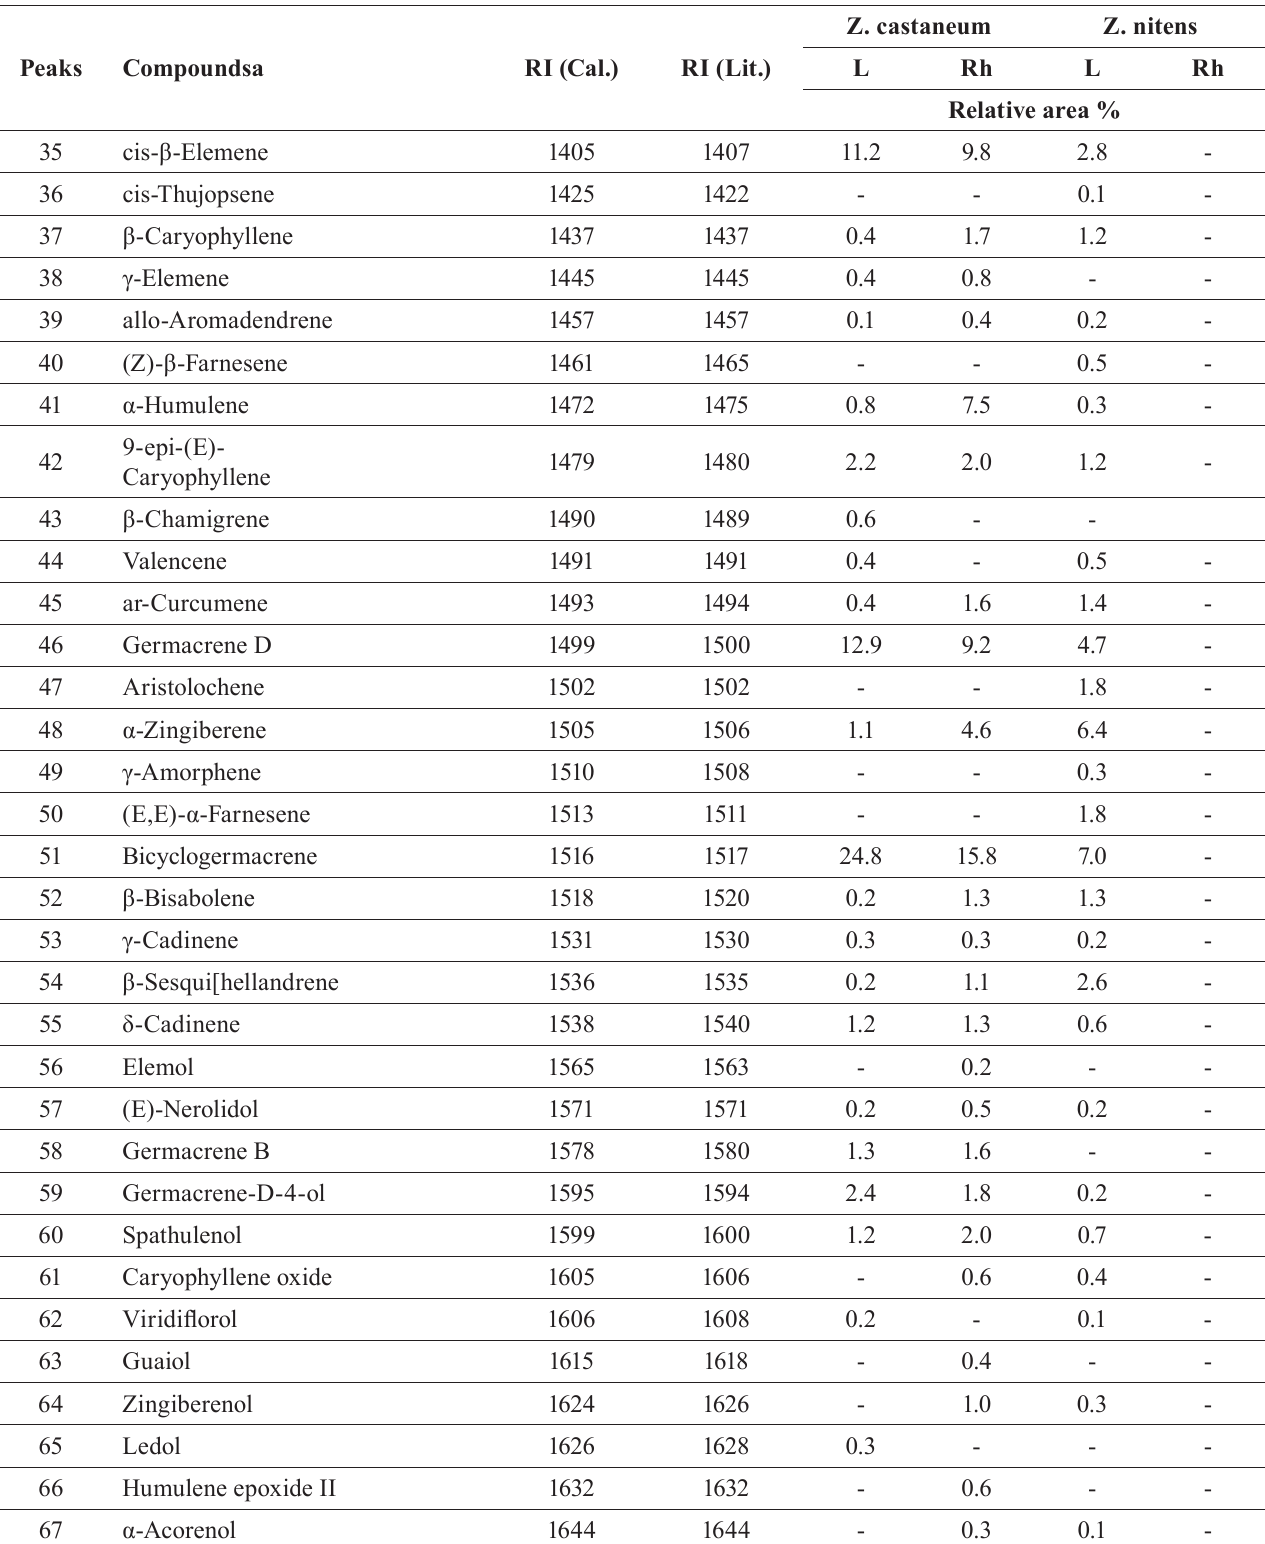
TABLE I - C hemical composition of Zingiber castaneum and Zingiber nitens leaf and rhizome essential oils.